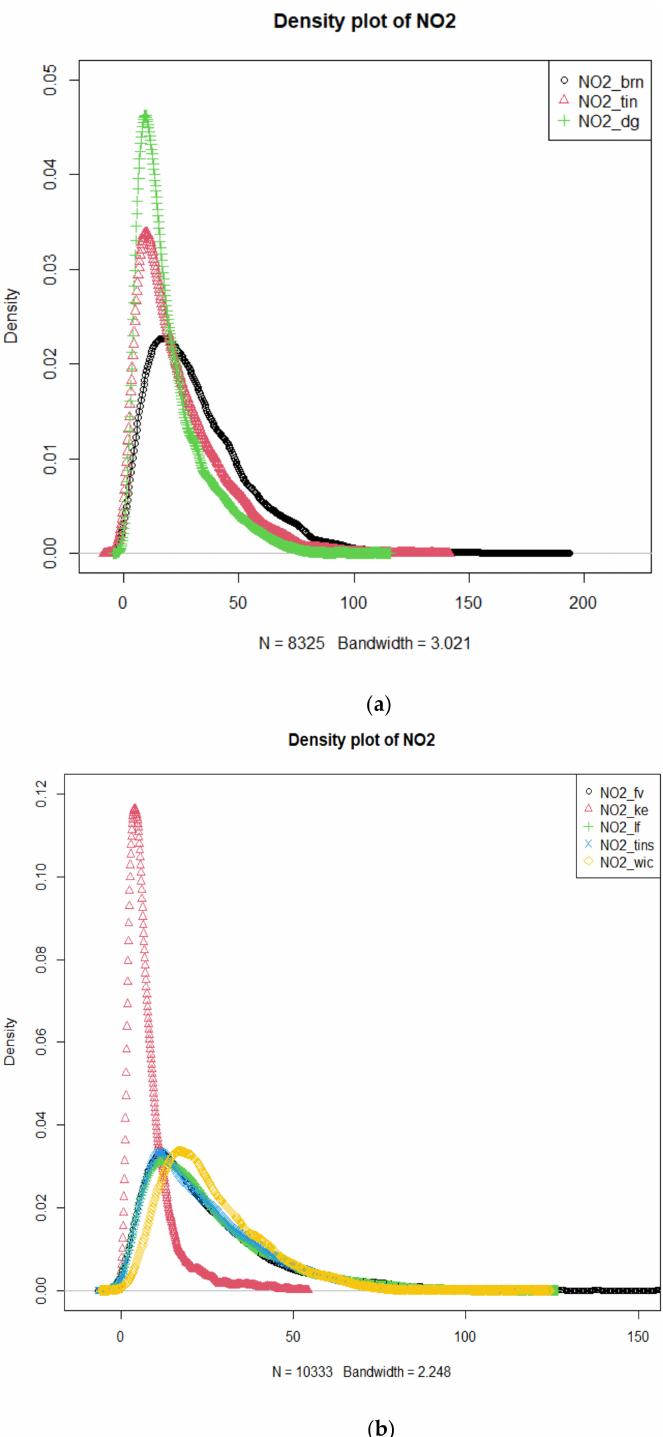
Figure 8. Density plots of NO 2 concentrations ( µ g/m 3 ) measured by: ( a ) AURN sites-Barnsley road (brn), Tinsley (tin) and Devonshire Green (dg); and ( b ) SCC sites-Firvale (fv), King Ecgbert (ke), Lowfield (lf), Tinsley (tins) and Wicker (wic), from August 2019–September